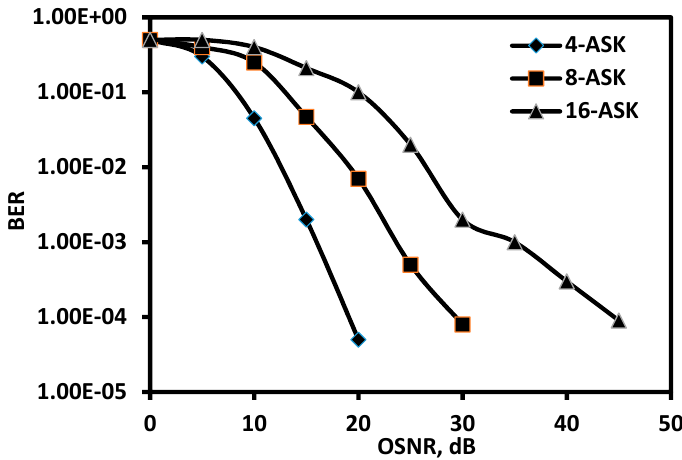
Figure 1. Optical signal-to-noise ratio (OSNR) vs. bit-error-rate (BER) performance of optical Fast-orthogonal frequency division multiplexing (Fast-OFDM) over an additive white Gaussian noise (AWGN) channel.